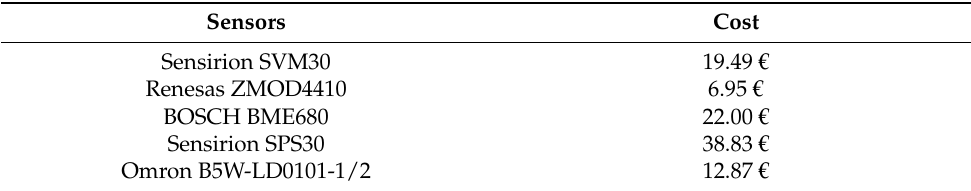
Table 5. IAQ sensors’ price